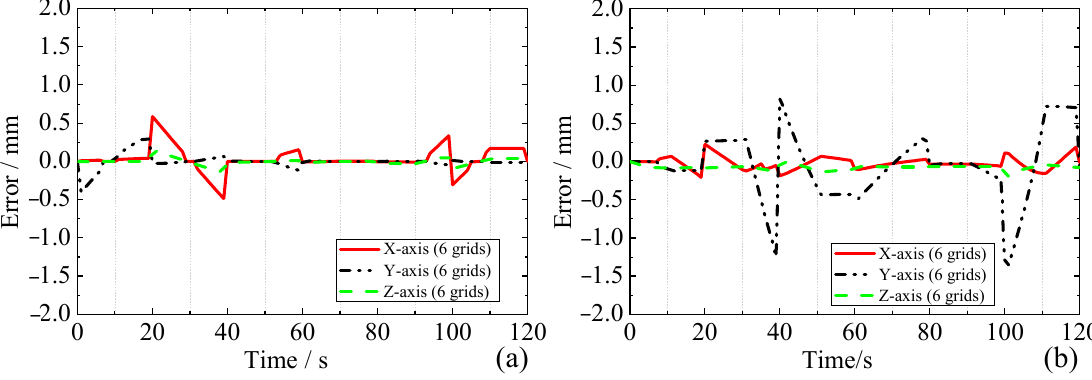
Figure 13. Lifting left outboard ( a ) and inboard ( b ) BB process end position error analysis. Table 3. Estimate error of the